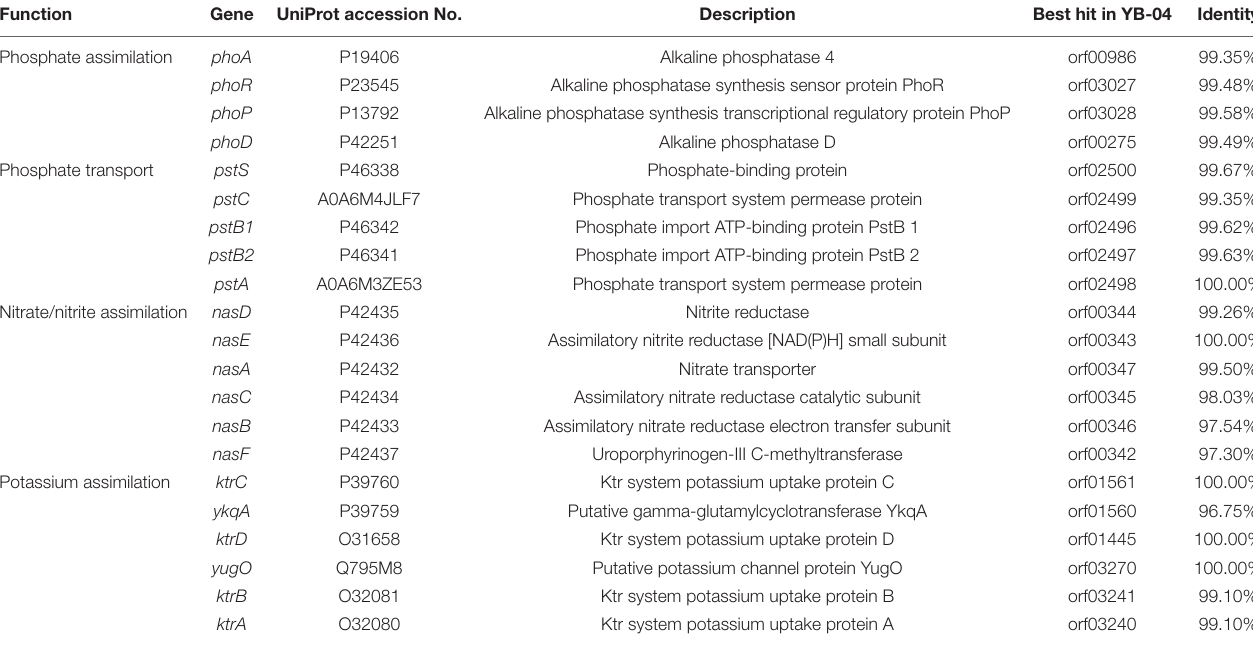
TABLE 5 | Genes responsible for nitrogen, phosphorous, and potassium assimilation identified in the strain YB-04 genome.